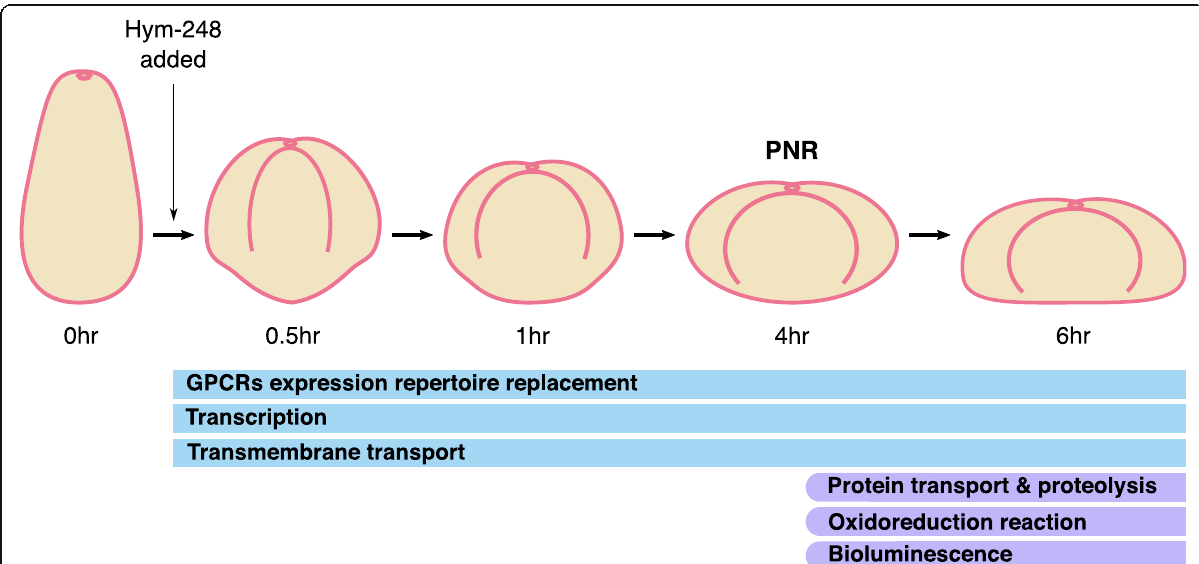
Fig. 5 Metabolic pathways expected to be important in the early metamorphosis induced by Hym-248. A model illustrating that in early metamorphosis (between 0 and 6 h; regardless of the PNR) in A. tenuis , GPCR expression repertoire replacement, transcription, and transmembrane transport play important roles. After the PNR, the onset of protein transport and proteolysis functions become more relevant to the loss of metamorphosis reversibility. The colors of bands (blue and purple) correspond to the colors of the modules (MD1 and MD6, respectively) where the relevant GO terms are enriched, as shown in Fig.